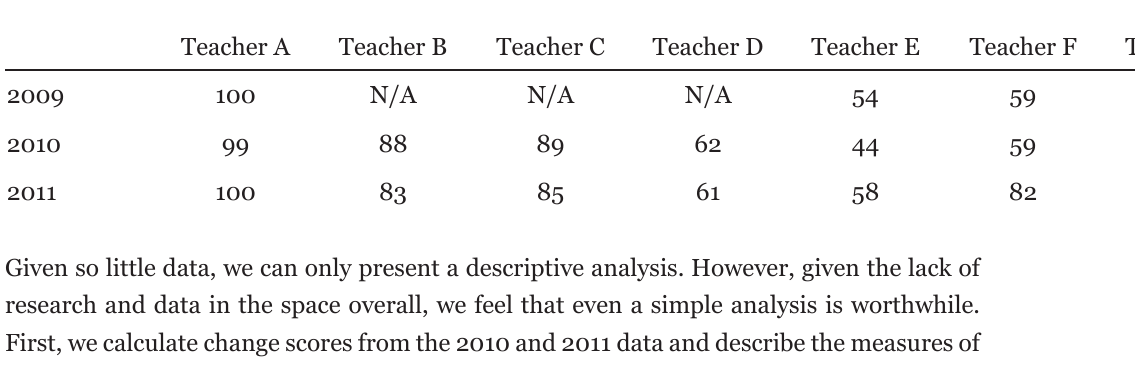
Summary of CRT Scores for Teachers Using Open Textbooks During Year 1